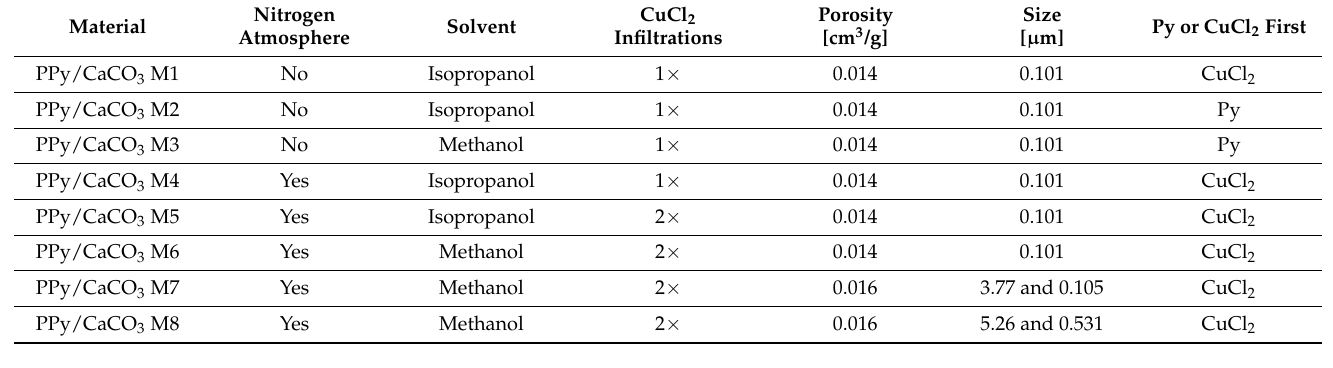
Table 1. Overview of PPy/CaCO 3 materials (PPy/CaCO 3 M1-M8) and their respective synthesis parameters including whether the synthesis was performed under a nitrogen atmosphere, solvent, amount of CuCl 2 infiltrations, the porosity and the size of the clam particles which were used as a template, whether Py or CuCl 2 added first in the synthesis.